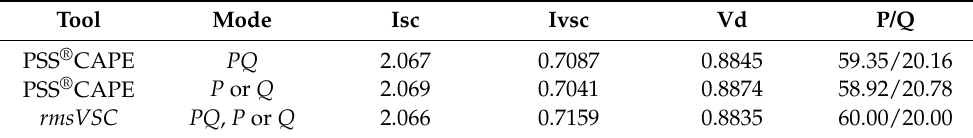
Table 1. Comparative results for case 1 (60 MW/20 MVAr).